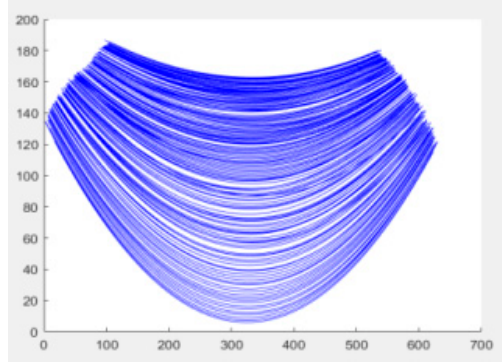
Figure 4. Image distance of 30cm to 110cm.